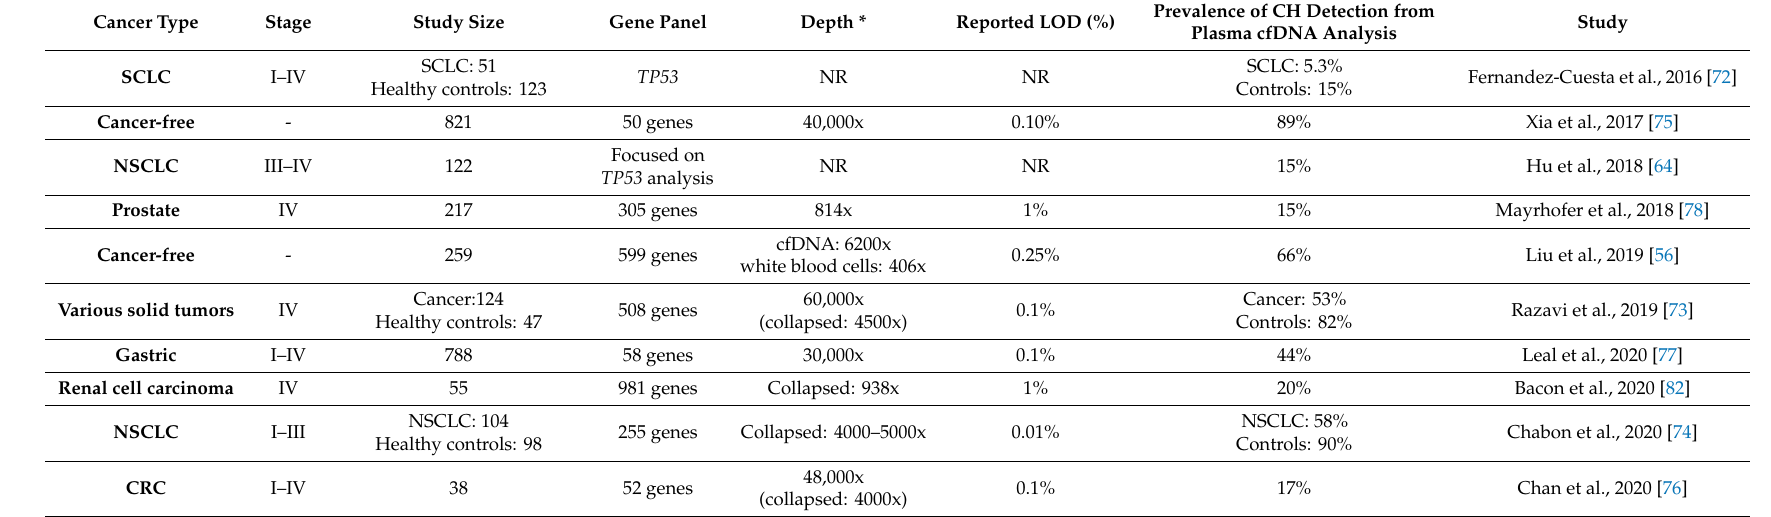
Table 2. Summary of published studies on the detection of CH mutations from plasma cell-free DNA (cfDNA)